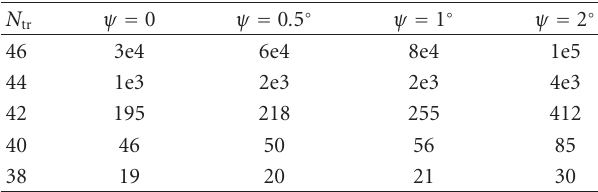
Table 4: Condition number of M obtained with p = I